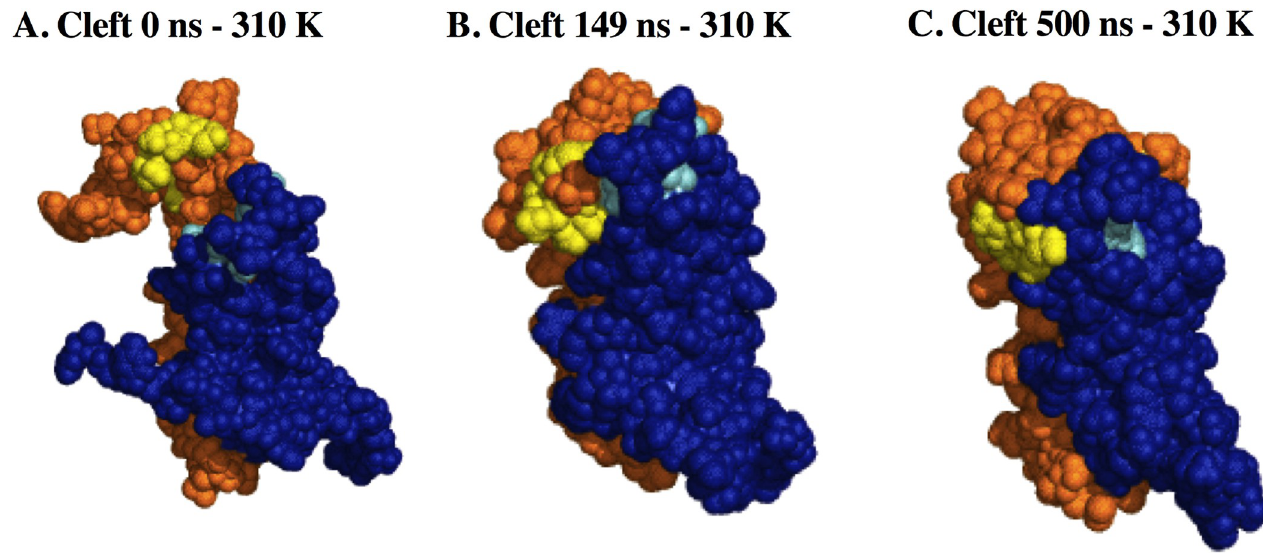
Fig 8. Cleft formation in EsxG EsxH dimer at 310 K. (A). 0 ns. (B). 149 ns. (C). 500 ns. Blue represents the EsxG monomer. Orange represents the EsxH monomer. Residues involved in cleft formation are presented in light blue (EsxG) and yellow